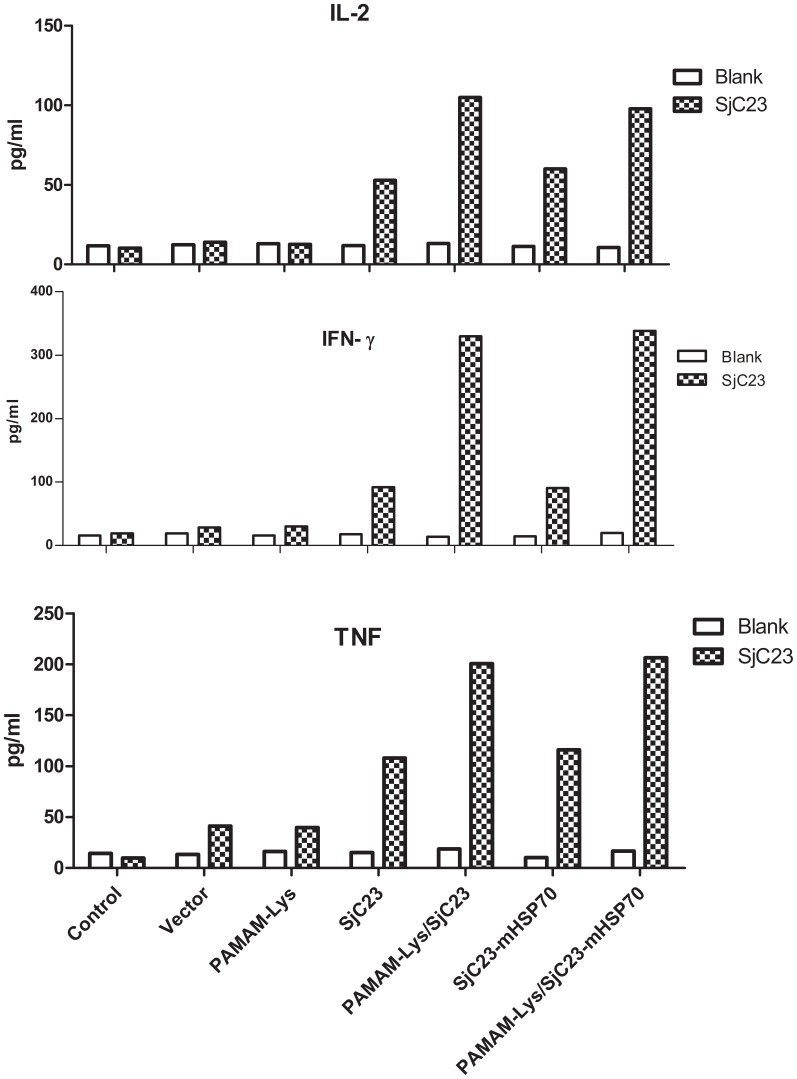
SjC23-specific cytokine responses in splenocytes induced by DNA vaccines,PAMAM-lys, PAMAM-lys/vaccines and empty vector.Data show IL-2, IFN–γ and TNF responses with SjC23 stimulation or blank control. The splenocytes were collected at 3 weeks after the 3rd DNA immunization.